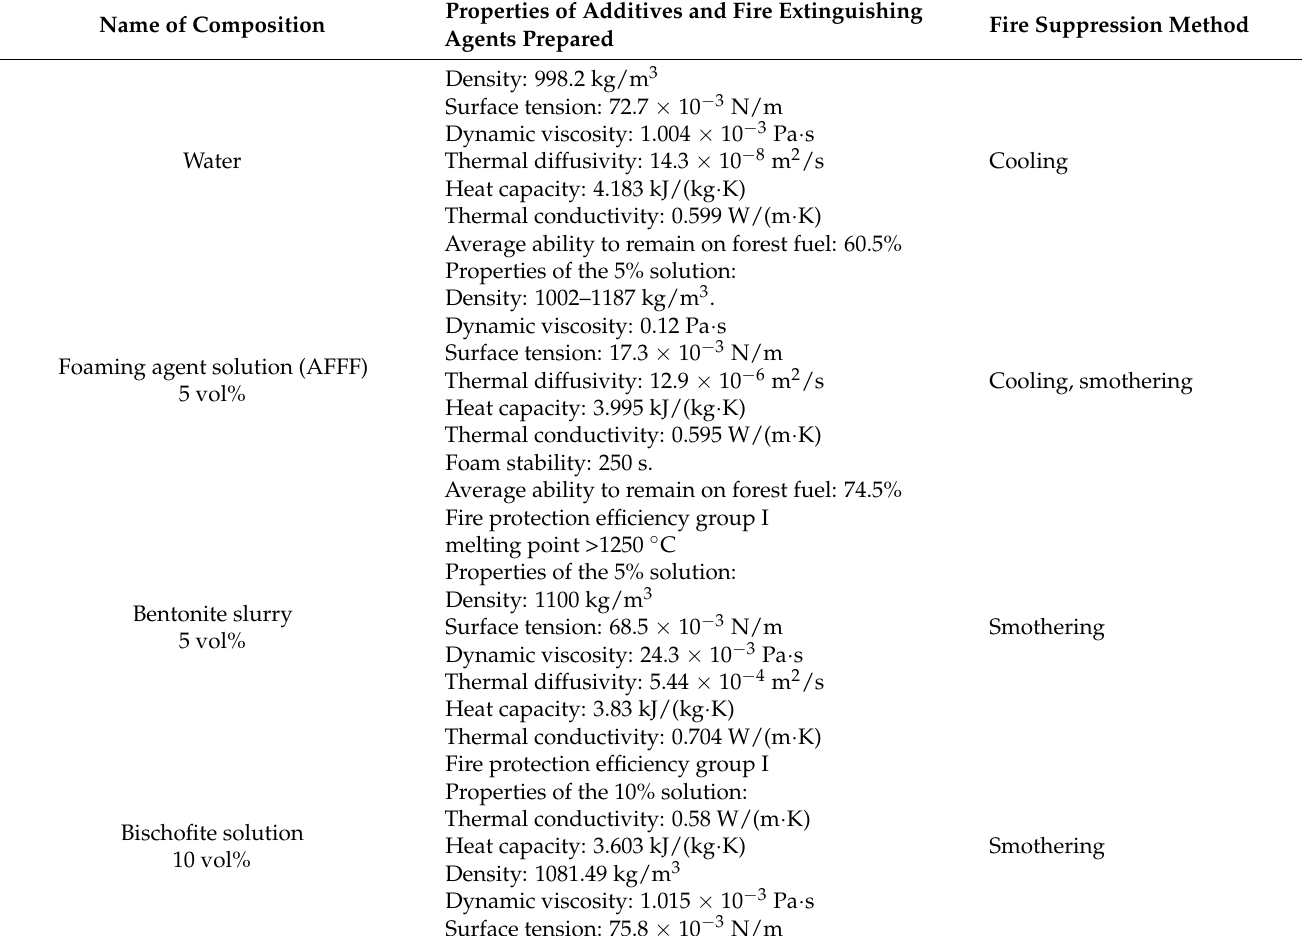
Table 2. Properties of components and solutions, slurries, and emulsions prepared